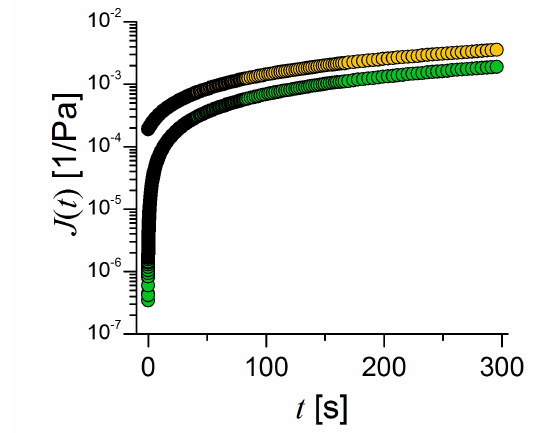
Figure A2: Soft (yellow) and firm (green) putties are subjected to a step-stess of 100 Pa to mimic loading during use for physical therapy applications, which are more readily thought of as stress- controlled loading scenarios. The resulting material strain 𝛾 is normalized by the input stress σ 0 and reported as a creep compli- ance J ( t ) . Intuitively, the softer putty (yellow) is more compliant than the firmer putty.